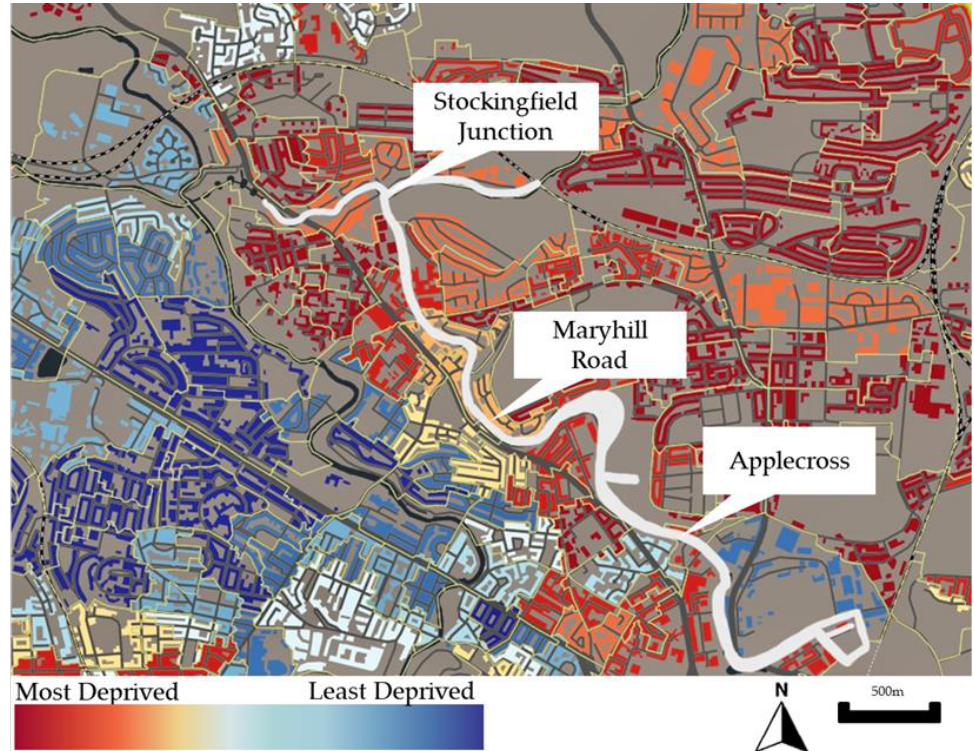
Figure 1. Annotated map of North Glasgow showing Scottish Index of Multiple Deprivation and three study sites (SIMD). Original 2020 map available at www.simd.scot (Contains public sector information licensed under the Open Government Licence v3.0” (from https://www.nationalarchives. gov.uk/doc/open-government-licence/version/3/)) (accessed on 3 September